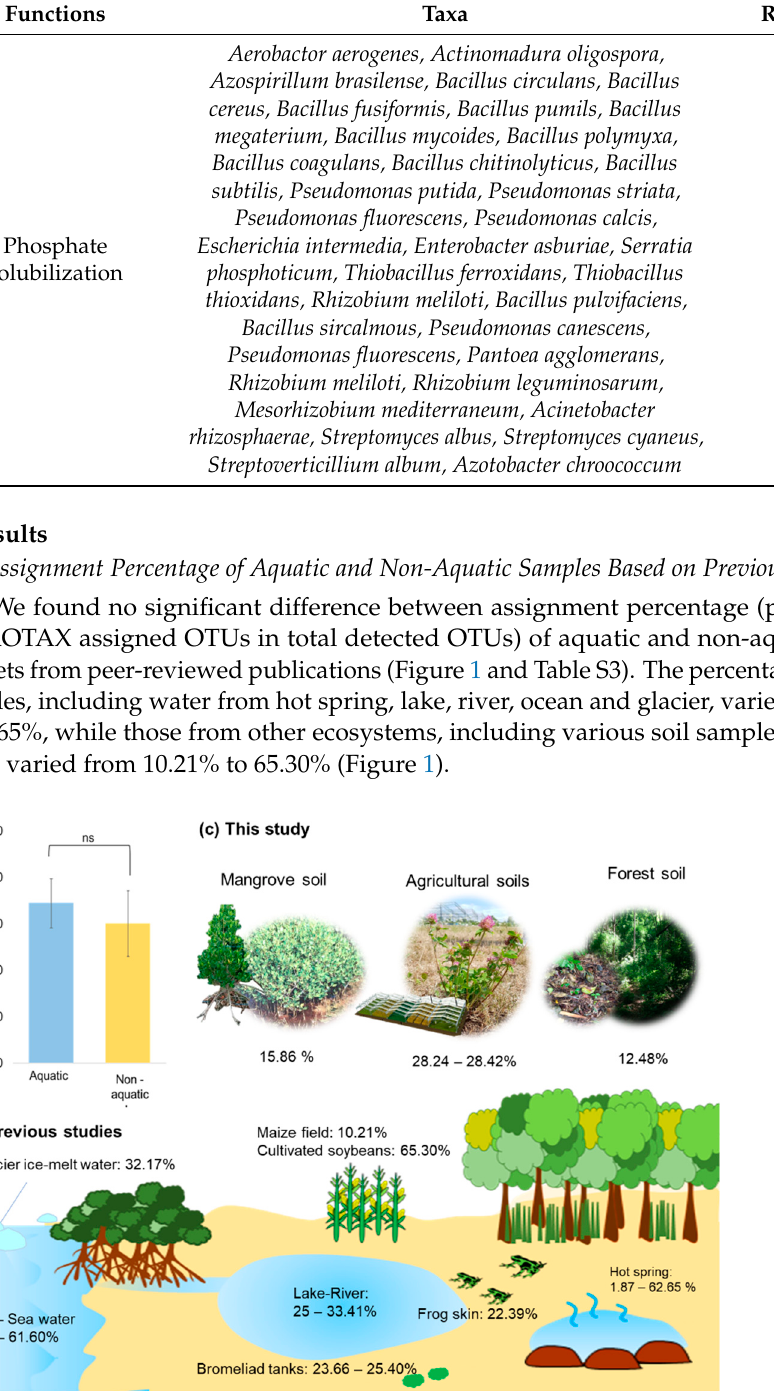
Figure 1. FAPROTAX assignment percentages over aquatic and non-aquatic ecosystems. ( a ) Bar plot showing the average proportion of FAPROTAX assignment based on previous studies of aquatic samples (blue) and non-aquatic samples (yellow). Error bars represent standard error of the mean and the letter “ns” indicates statistical insignificance tested by Mann-Whitney U test. ( b ) FAPROTAX assignment percentage over different sample sources based on previous literature. ( c ) The assignment percentage found in soil samples from mangrove, agriculture and forest ecosystems in this present study.